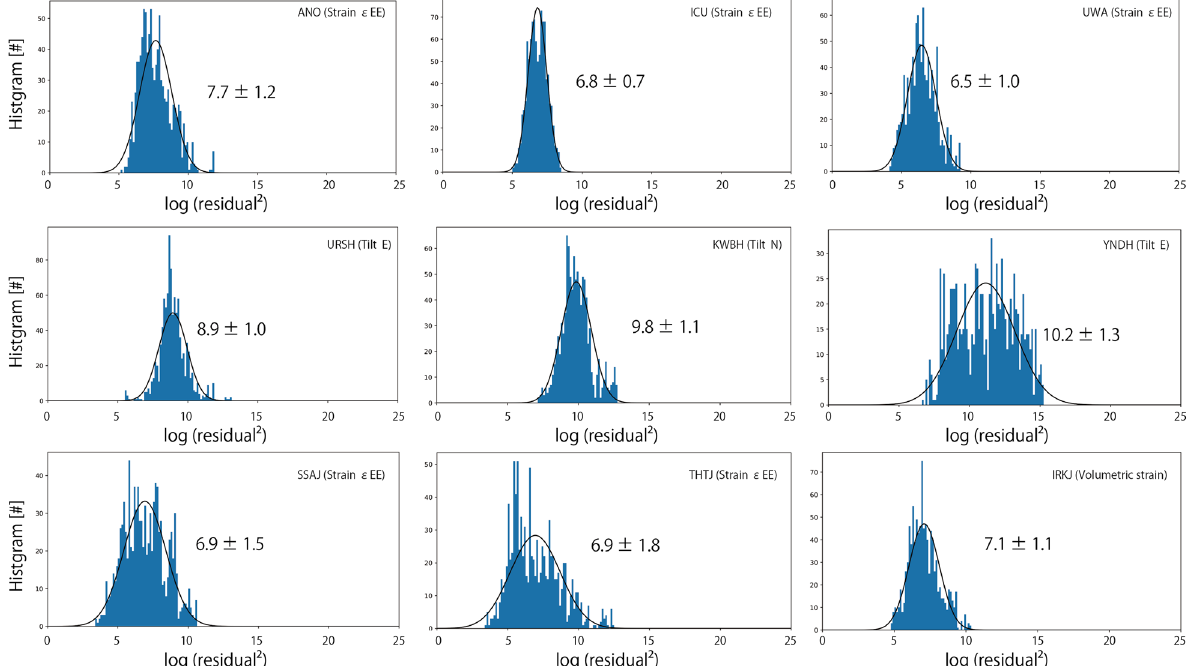
Fig. 3 Histograms of residuals for fitting a linear function to strain and tilt data. Each panel shows an example of histogram for different stations and components. Black curves represent log-normal distributions fitted for the histogram. Values in the panels are the means and standard deviations of the fitted log-normal